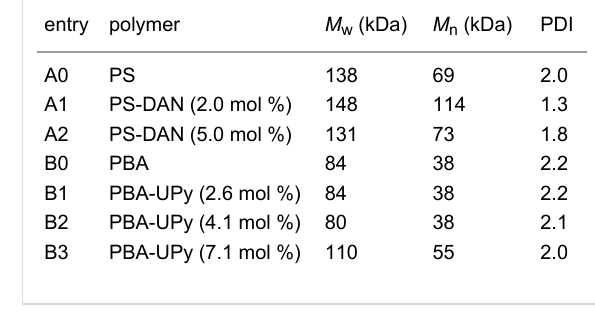
acrylate) (PBA) and 2-ureido-4(1 H )-pyrimidone (UPy) modi- fied poly(butyl acrylate) (PBA-UPy) were prepared and charac- terized by THF SEC against PS standards according to a known procedure [57]. The loading of the UPy units, determined by 1 H NMR, is listed in Table 1.